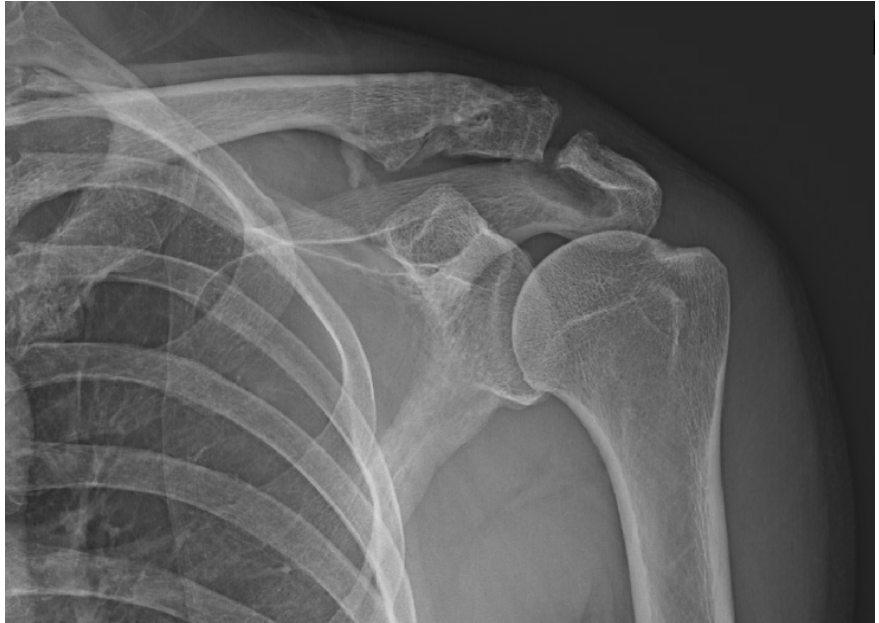
Figure 2. Acromial bony erosion. Varying degrees of bony erosions re observed in terms of eroded size and depth, which can be identified after plate removal.